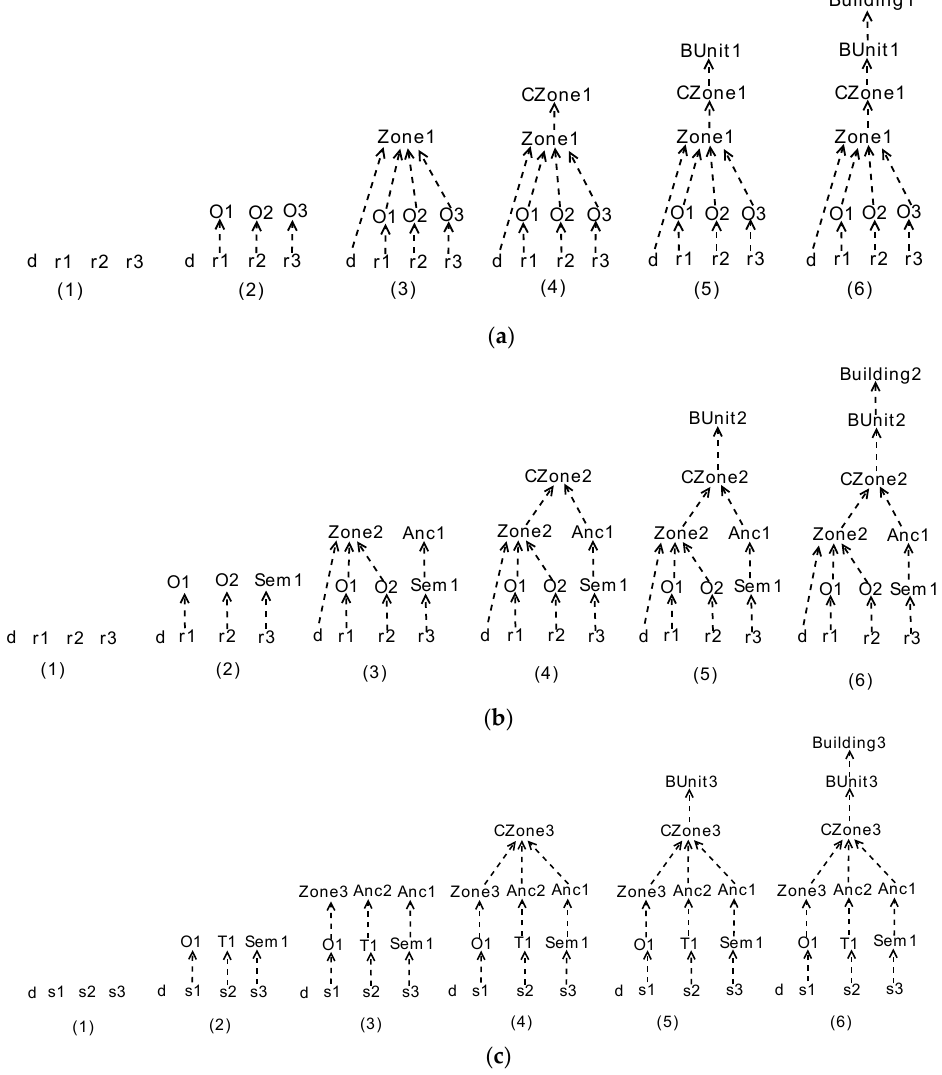
Figure 8. Pruning incomplete trees from parse forest. We take a simplified floor-plan (shown in Figure 6) as an example to illustrate the procedure of creating the parse forest by using the proposed bottom-up method. The floor plan consists of three rooms, one internal and three external doors (denoted by solid red lines), and a corridor (with a yellow background). Based on this floor plan, hundreds of parse trees can be generated that form the parse forest. Here, we only choose three parse trees as examples. To clearly illustrate the bottom-up